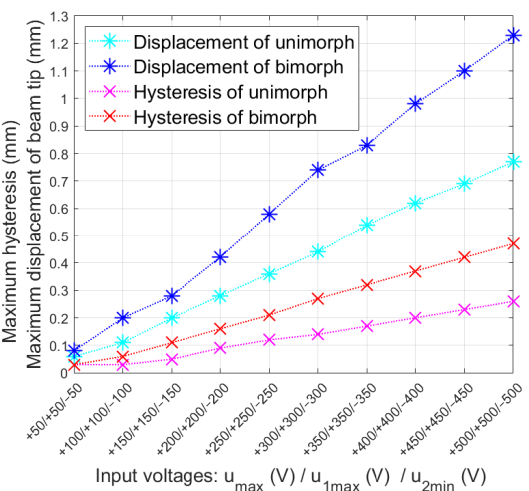
Figure 5. Hysteresis loops: ( a ) displacement of a unimorph for u max = +250 V, ( b ) displacement of a bimorph for u 1max = +250 V and u 2max = –250 V, ( c ) displacement of a unimorph for u max = +500 V, ( d ) displacement of a bimorph for u 1max = +500 V and u 2max = –500 V. A comparison of maximums of actuator beam tip displacement and maximums hys- teresis is presented in Figure 6.